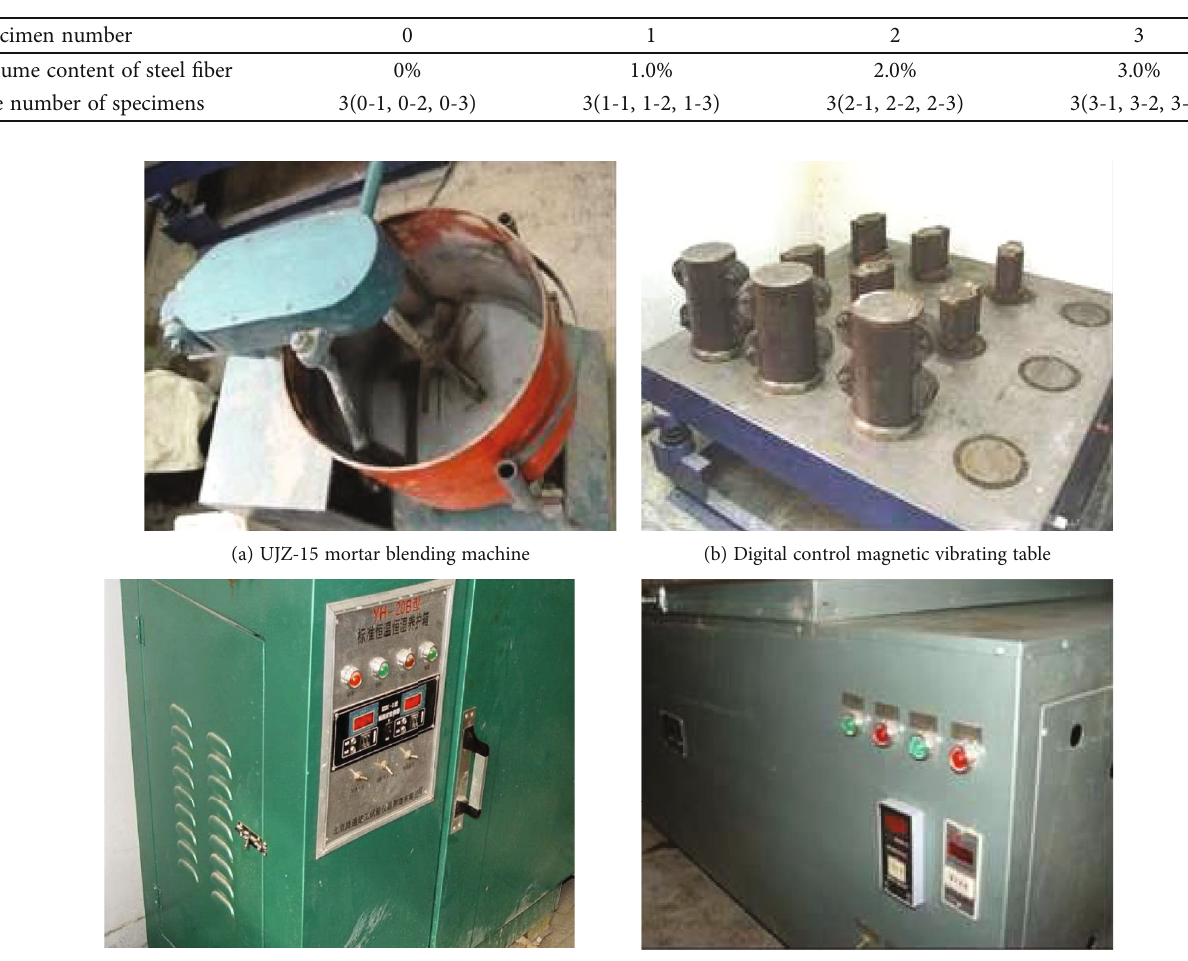
Figure 1: Testing equipment.